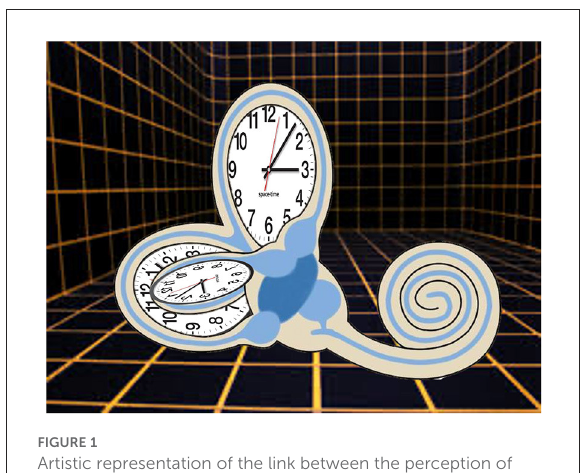
FIGURE1 Artistic representation of the link between the perception of time and the vestibular system. Credit: Laurence Harris, York